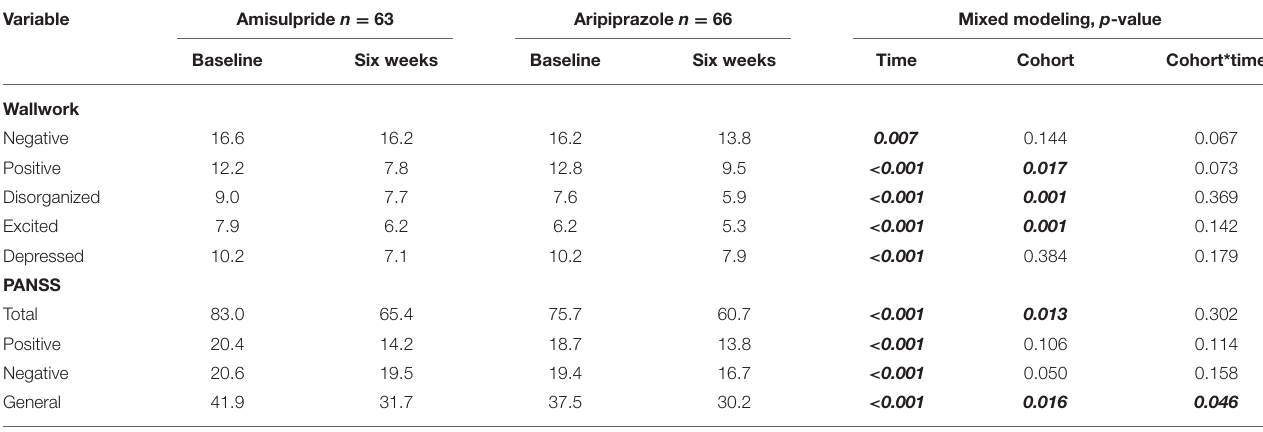
TABLE 3 | Estimated means and p values from the mixed modeling analyses on the whole sample. Variable